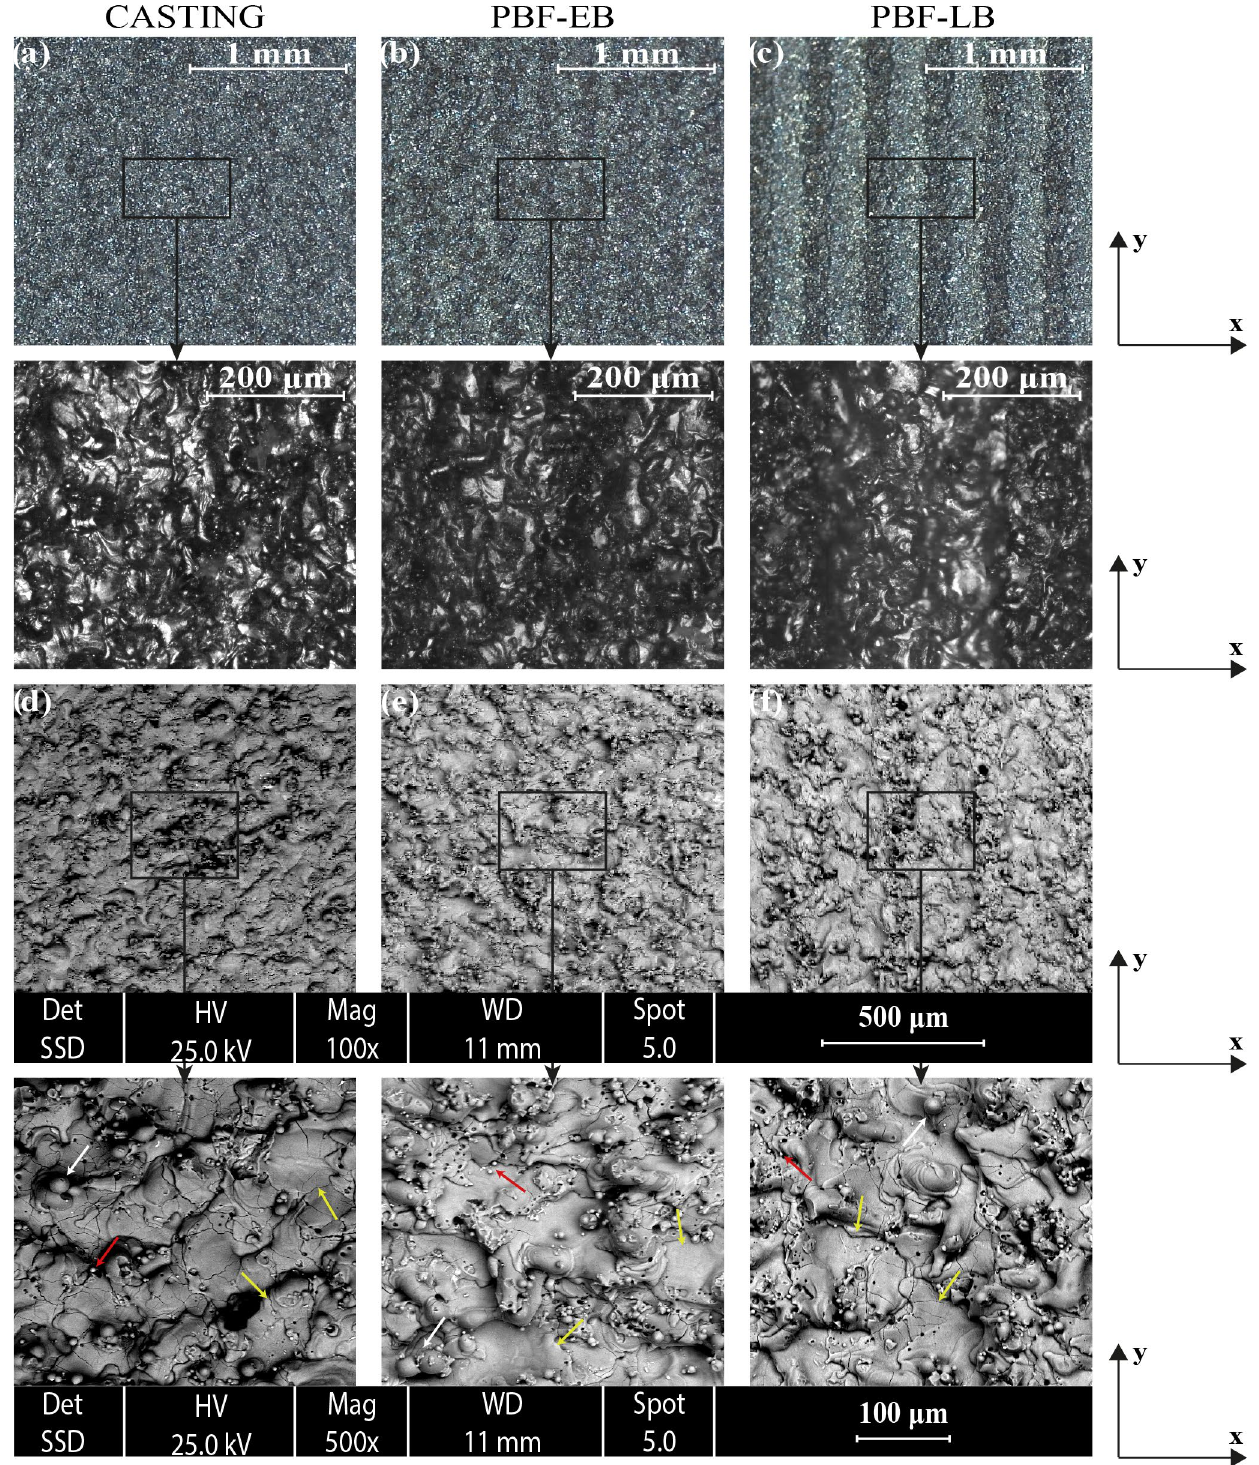
Figure 3. Surface textures observed with ( a – c ) microscope and ( d – f ) SEM on samples produced by ( a , d ) casting, ( b , e ) PBF-EB, and ( c , f ) PBF-LB, machined with the same set of process parameters (t on = 10 s, DC = 8.33%, I = 3 A, workpiece thickness = 20 mm). White arrows indicate examples of spherical debris; red arrows indicate examples of residuals from the wire, while yellow arrows provide an example of craters produced on the workpiece surface by the W-EDM process. The x -axis is parallel to the cut direction.